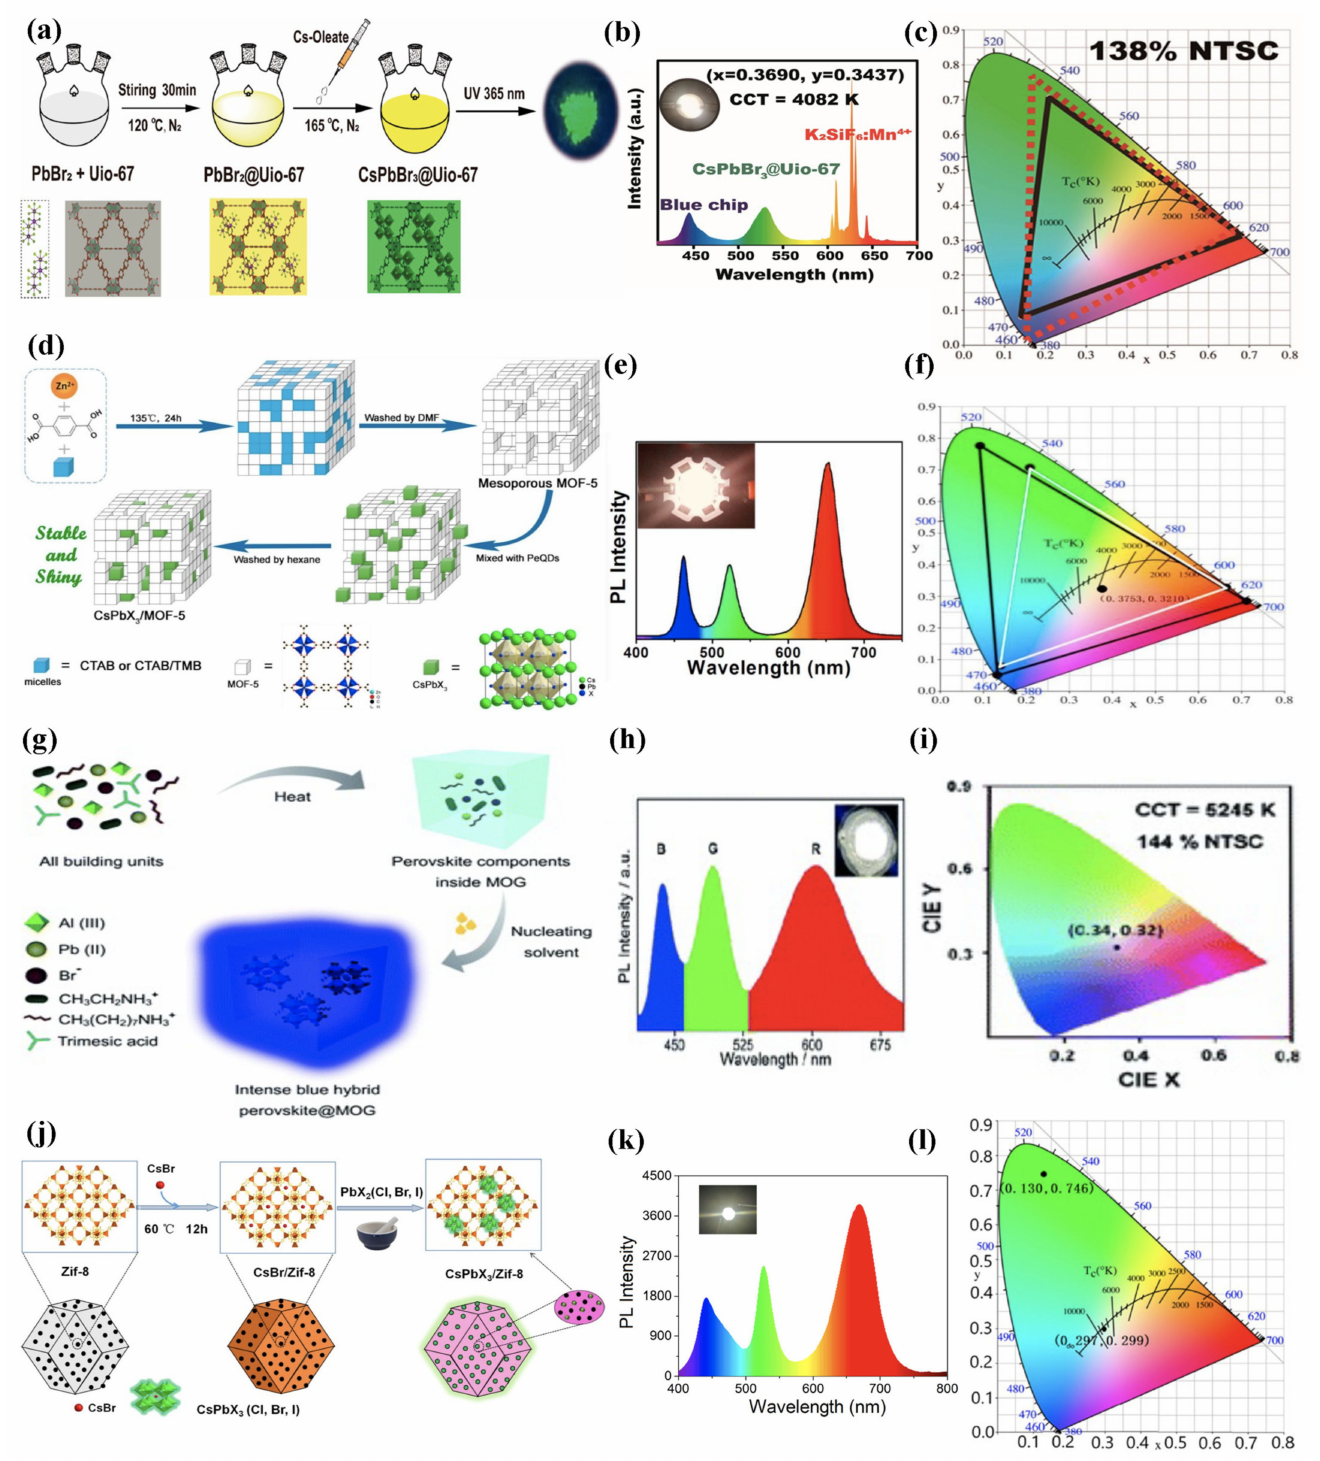
Figure 3. ( a ) Proposed synthesis procedure for the formation of typical CsPbBr 3 @UiO-67 composite and the correspond- ing structural models. ( b ) PL spectrum of the as-fabricated WLEDs with CsPbBr 3 @UiO-67 composite and commercial K2SiF6:Mn4+ red phosphor deposited on the blue-chip (InGaN, 455 nm). Inset: Photograph of the WLEDs (x: 0.3690, y: 0.3437). ( c ) CIE colour space coordinates of as-fabricated WLEDs showing a wide colour gamut (138% NTSC). Adapted with permission from ref. [105]. Copyright 2019, American Chemical Society. ( d ) Synthesis strategy of the mesoporous MOF-5 crystals and the CsPbX 3 /MOF-5 composites. ( e ) PL spectrum of the CsPbX 3 /MOF-5, red CsPbBr 0.6 I 2.4 /MOF-5, and the blue InGaN chip (black line) compared with the NTSC standard (white line). ( f ) CIE colour coordinates of the W-LED